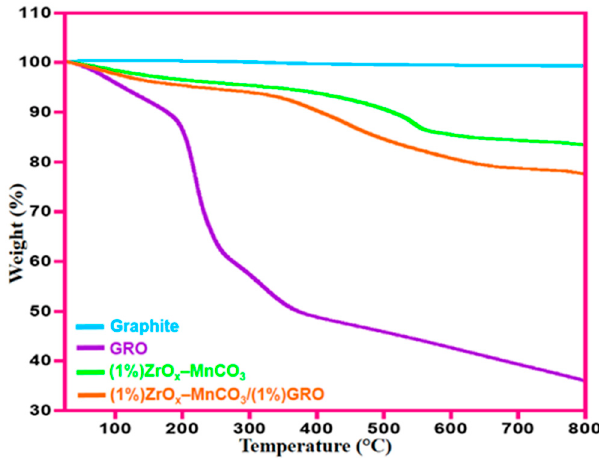
Figure 2. TGA curves of the graphite, GRO, (1%)ZrO x –MnCO 3 , and (1%)ZrO x –MnCO 3 /(1%)GRO.